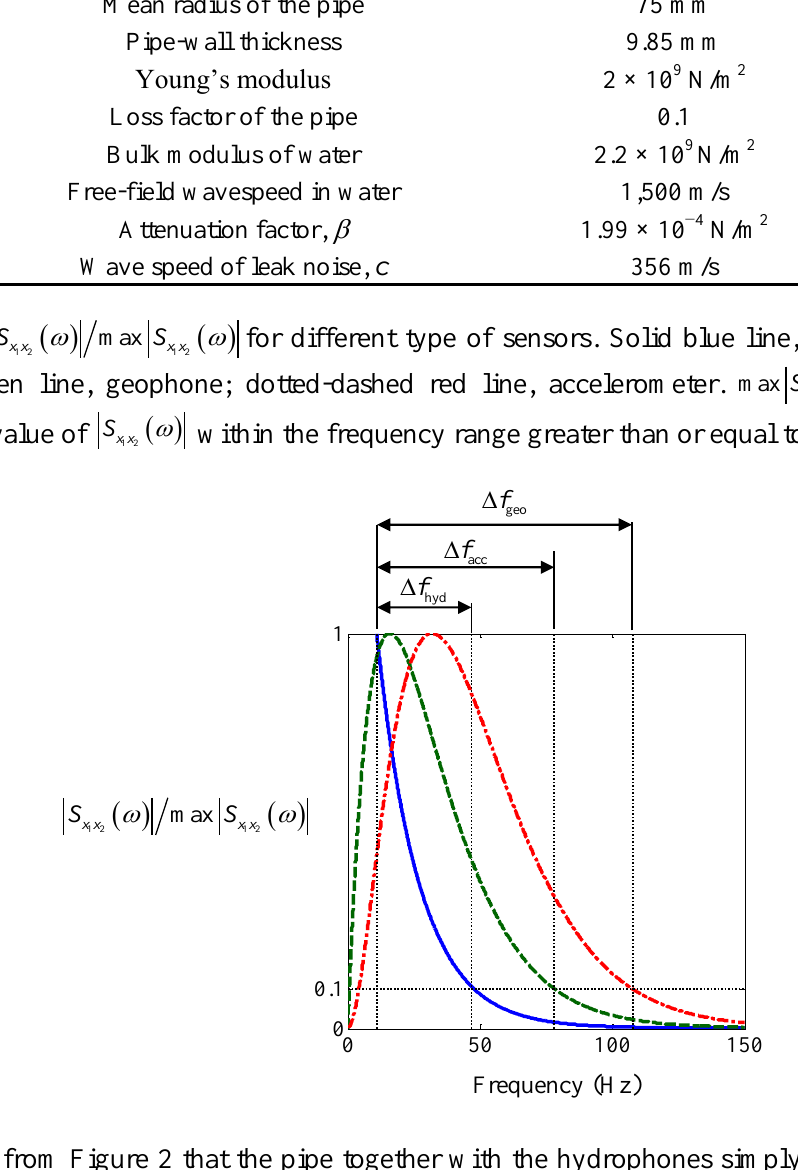
Table 1. Properties of the experimental test-rig.